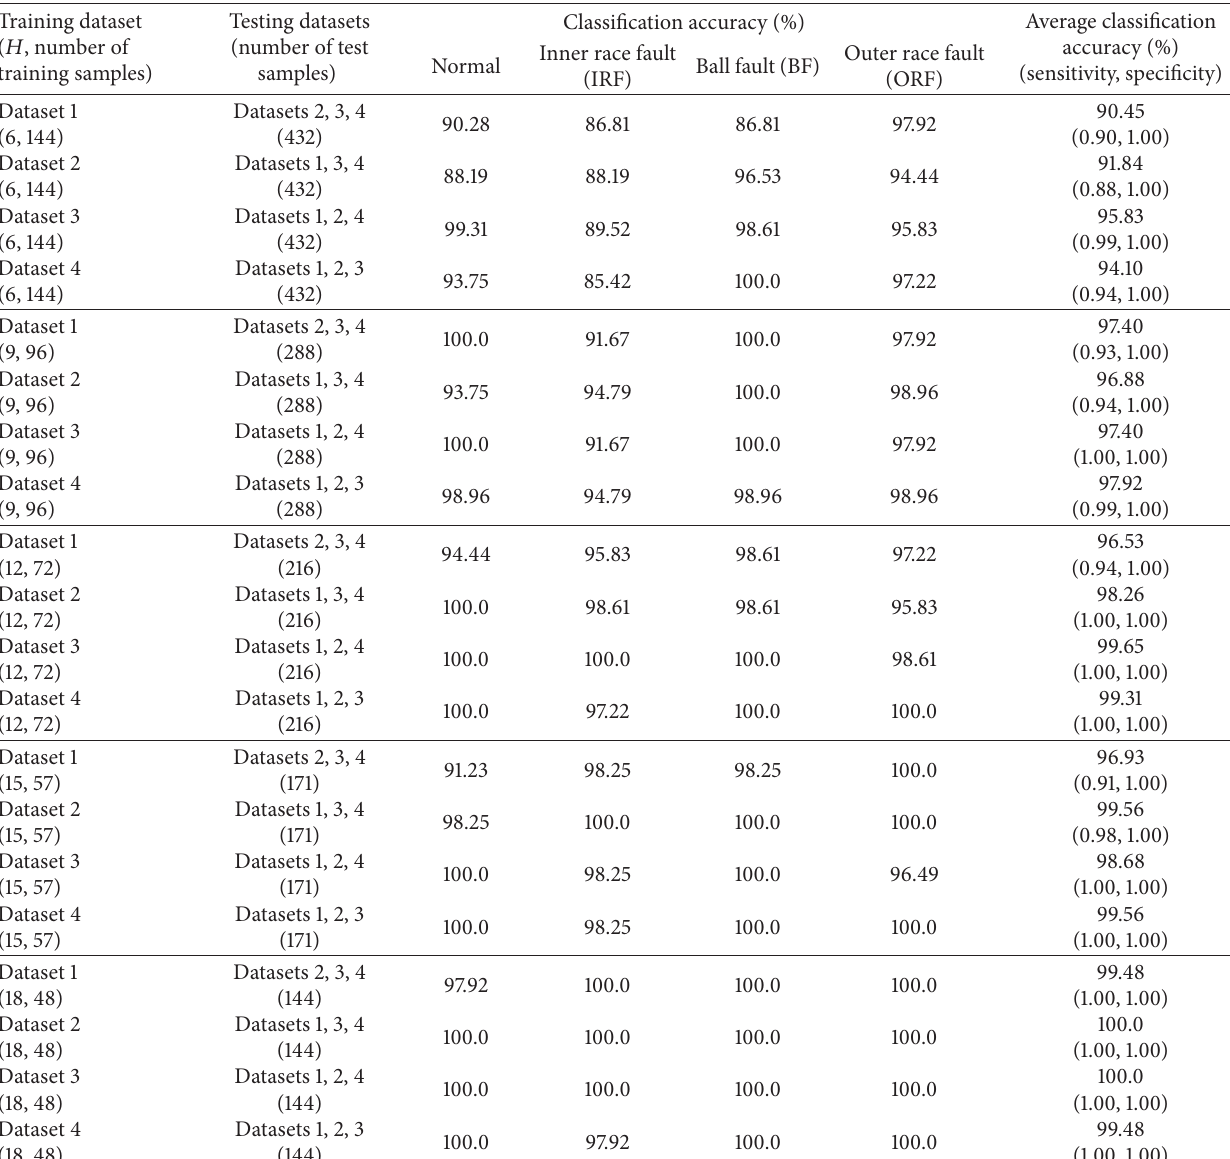
Figure 6: Effect of image height ( 𝐻 ) on the average classification accuracy (ACA) for normal, inner, ball or roller, and outer raceway faults. Table 4: Diagnostic performance of the proposed scheme under different